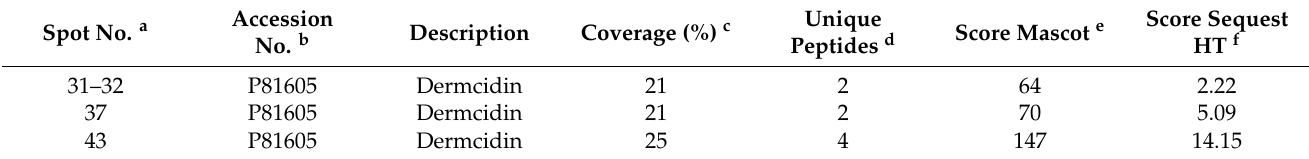
Table 3. Dermcidin validation by mass spectrometry.